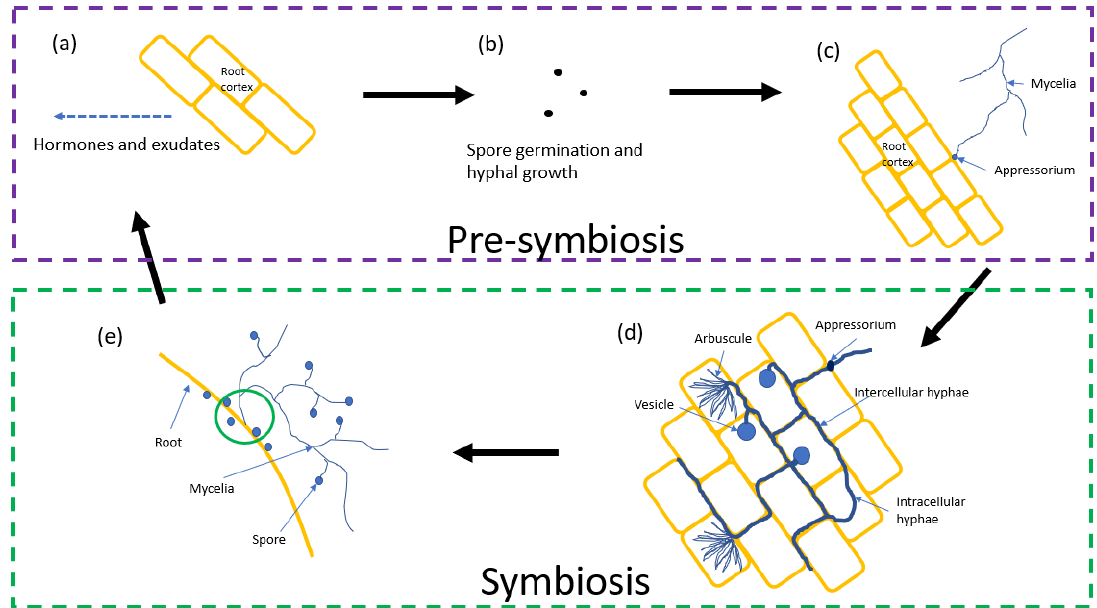
Figure 1. Diagrammatic representation, based on the model organism Triticum aestivum L., of the AM fungal life cycle through initial plant signalling ( a ), spore germination ( b ), and initial plant infection ( c ) in pre-symbiosis. Following infection, establishment of intracellular root cortical fungal structures ( d ) establishes plant–fungus symbiosis. Extra radiating mycelia are also available for growth and development from further plant exudated compounds to establish multi-plant symbiosis ( e ). Root arbuscules are not to scale with cortical cells.